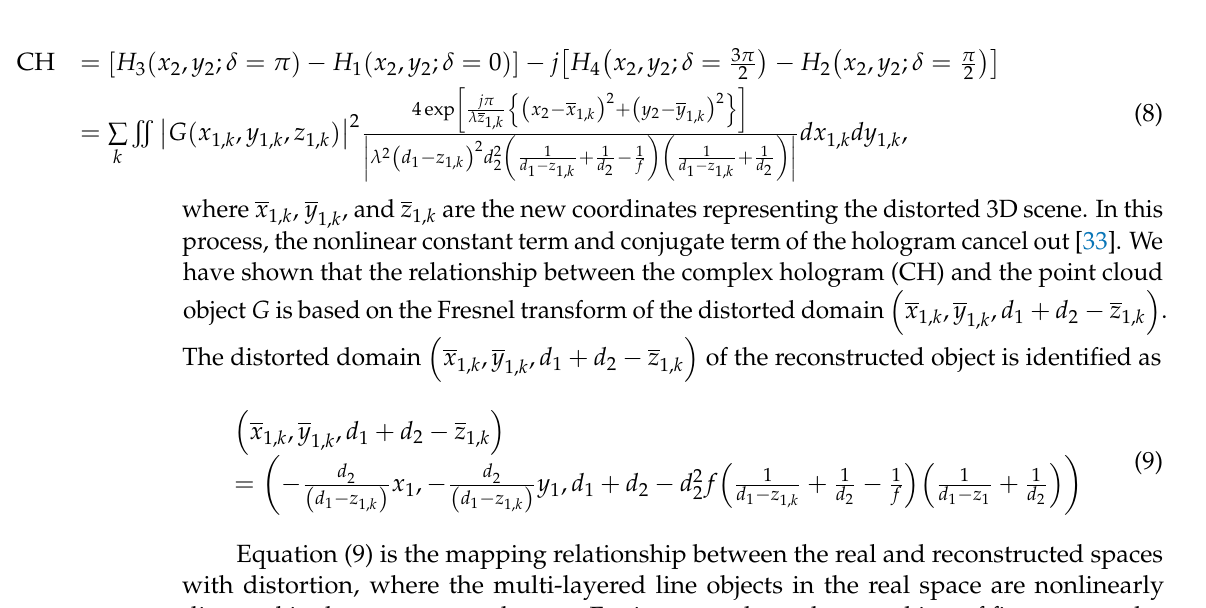
Figure 3. Phase profiles of complex field distributions on the image sensor: ( a ) the modulated wave (GFrT) and ( b ) the non-modulated wave (FrT). Phase shifted intensity profiles ( c ) 1 H , ( d ) 2 H , ( e ) 3 H , and ( f )